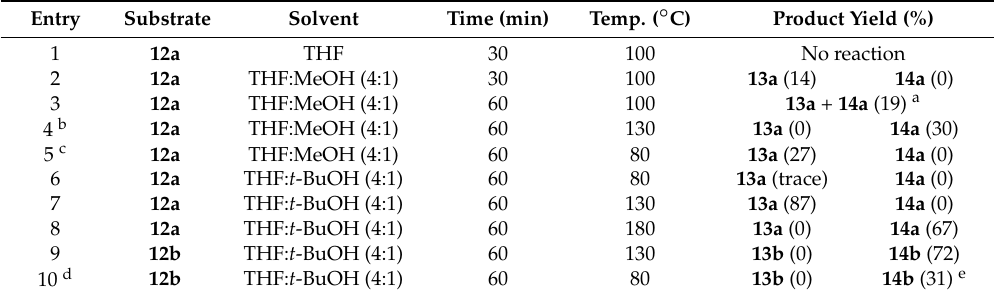
Table 2. Potassium t -butoxide promoted dehydrohalogenation of 12.